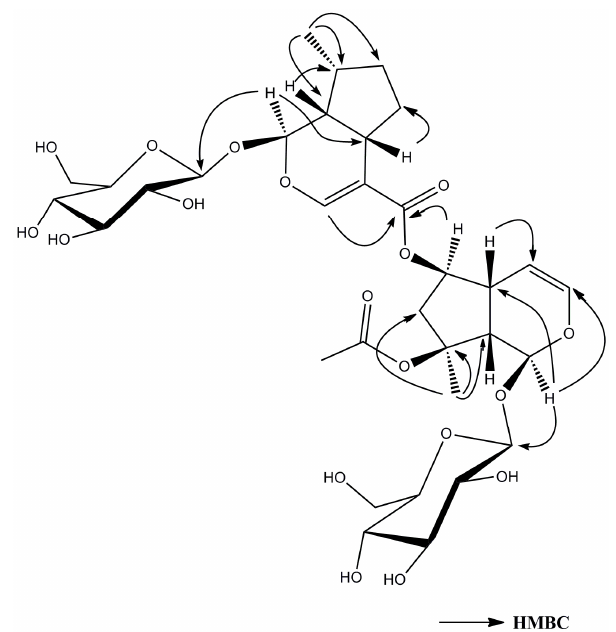
Figure 2. Selected heteronuclear multiple bond correlations (HMBC) for compound 1 .